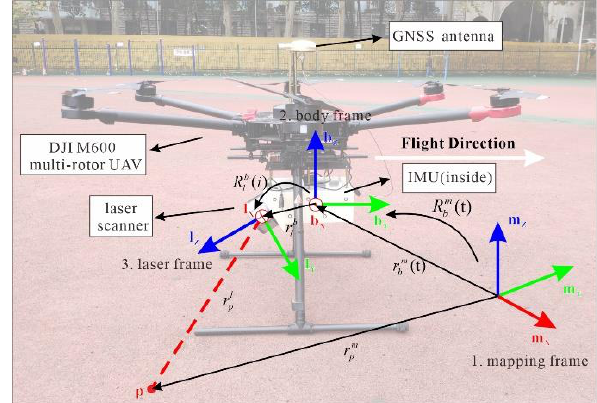
Fig.2 Coordinate definitions involved in the proposed low-cost UAV-LiDAR system: